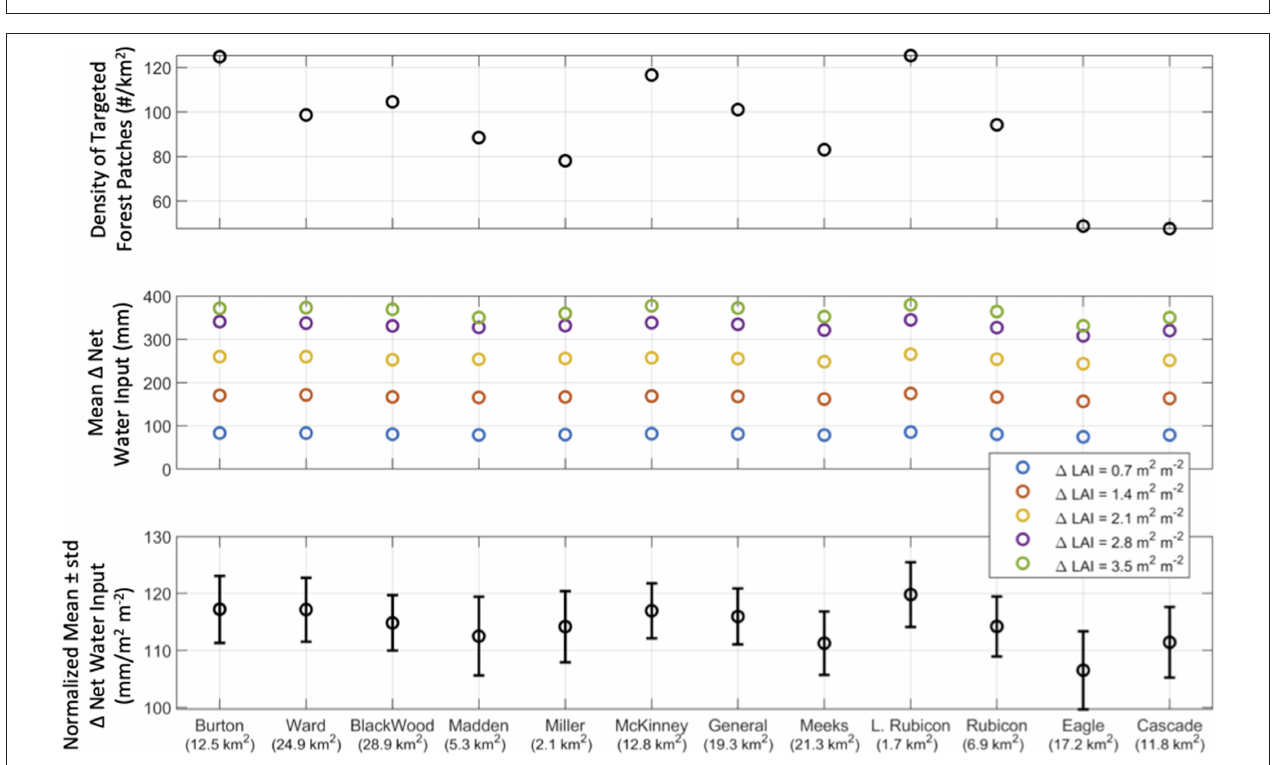
FIGURE 12 | Predicted increase in the total melt volume by the Random Forest model for a dense forest patch with mean LAI and height of 3 m 2 /m 2 and 10m, respectively, and two thinning scenarios: moderate (0.6 m 2 /m 2 ) and significant (2.4 m 2 /m 2 ) thinning. A negative northness index represents a more north oriented slope, with − 1 representing a completely north-facing slope.